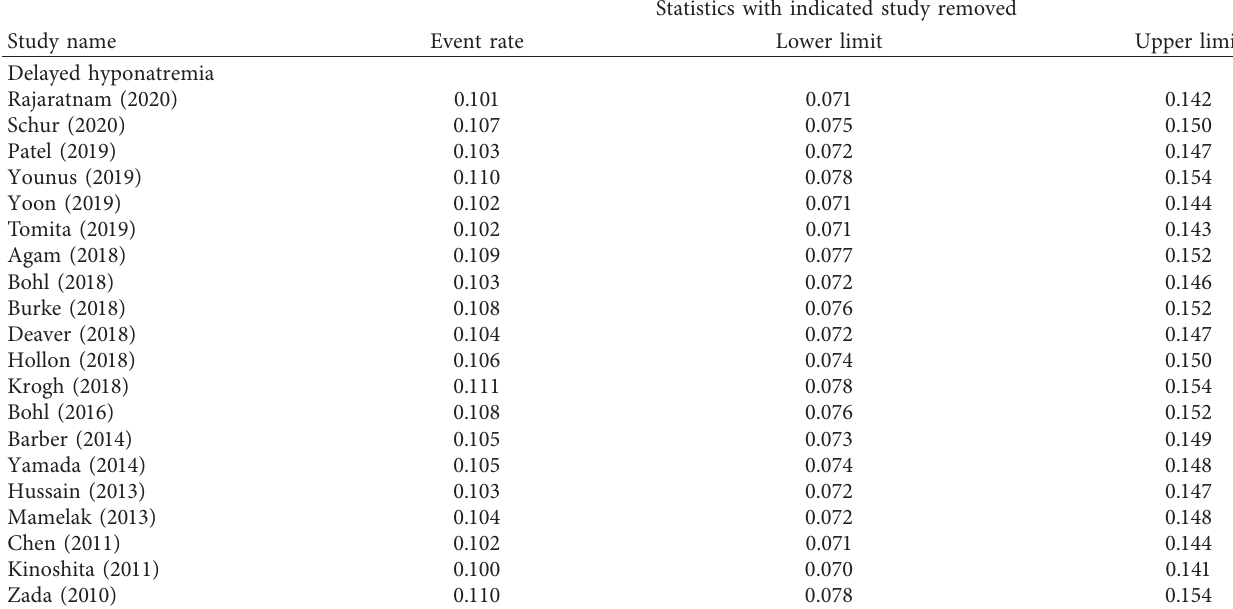
Table 4: A sensitivity analysis. Statistics with indicated study